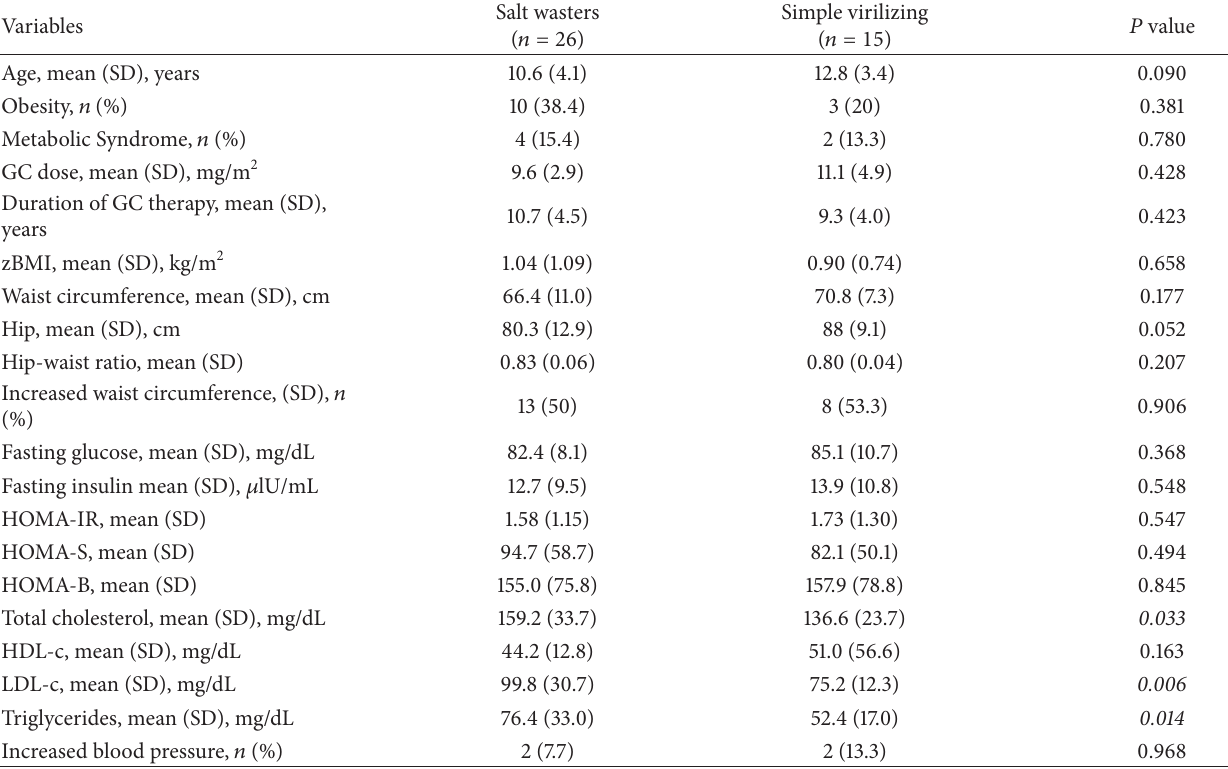
Table 1: Clinical and anthropometric characteristics of 41 pediatric CAH